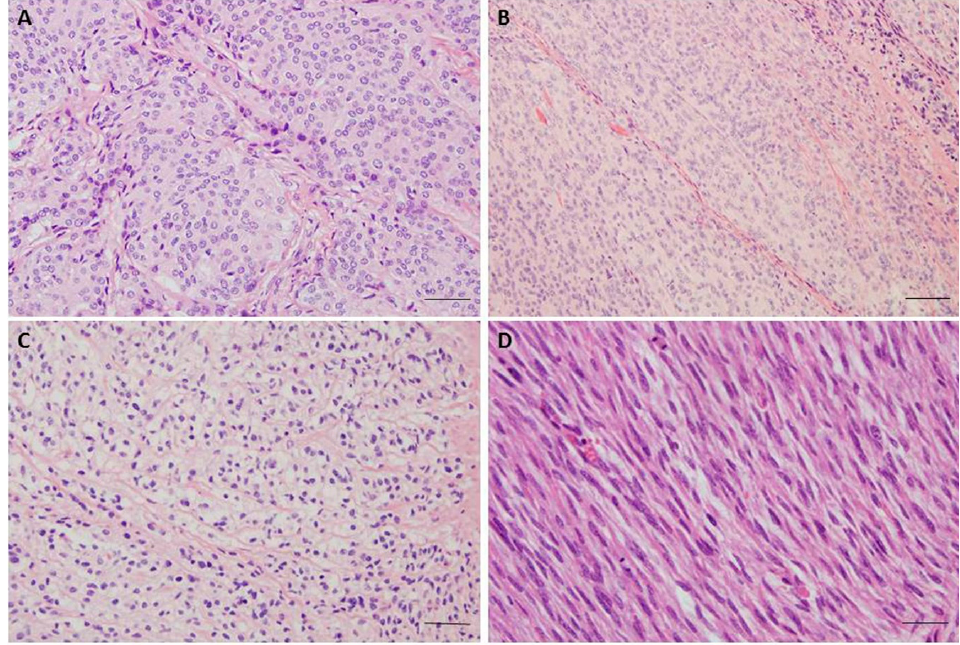
Figure 1. ( A ) Meningothelial meningioma, Grade 1; H & E staining, 200× magnification, showing typical whorl formations; ( B ) Atypical Meningioma, Grade 2; H & E staining, 200× magnification, with increased cellularity, sheet ‐ like growth, high nuclear/cytoplasmic ratio and prominent nucleoli; ( C ) Clear cell meningioma, Grade 2; H & E staining, 200× magnification, meningothelial cell neoplasm